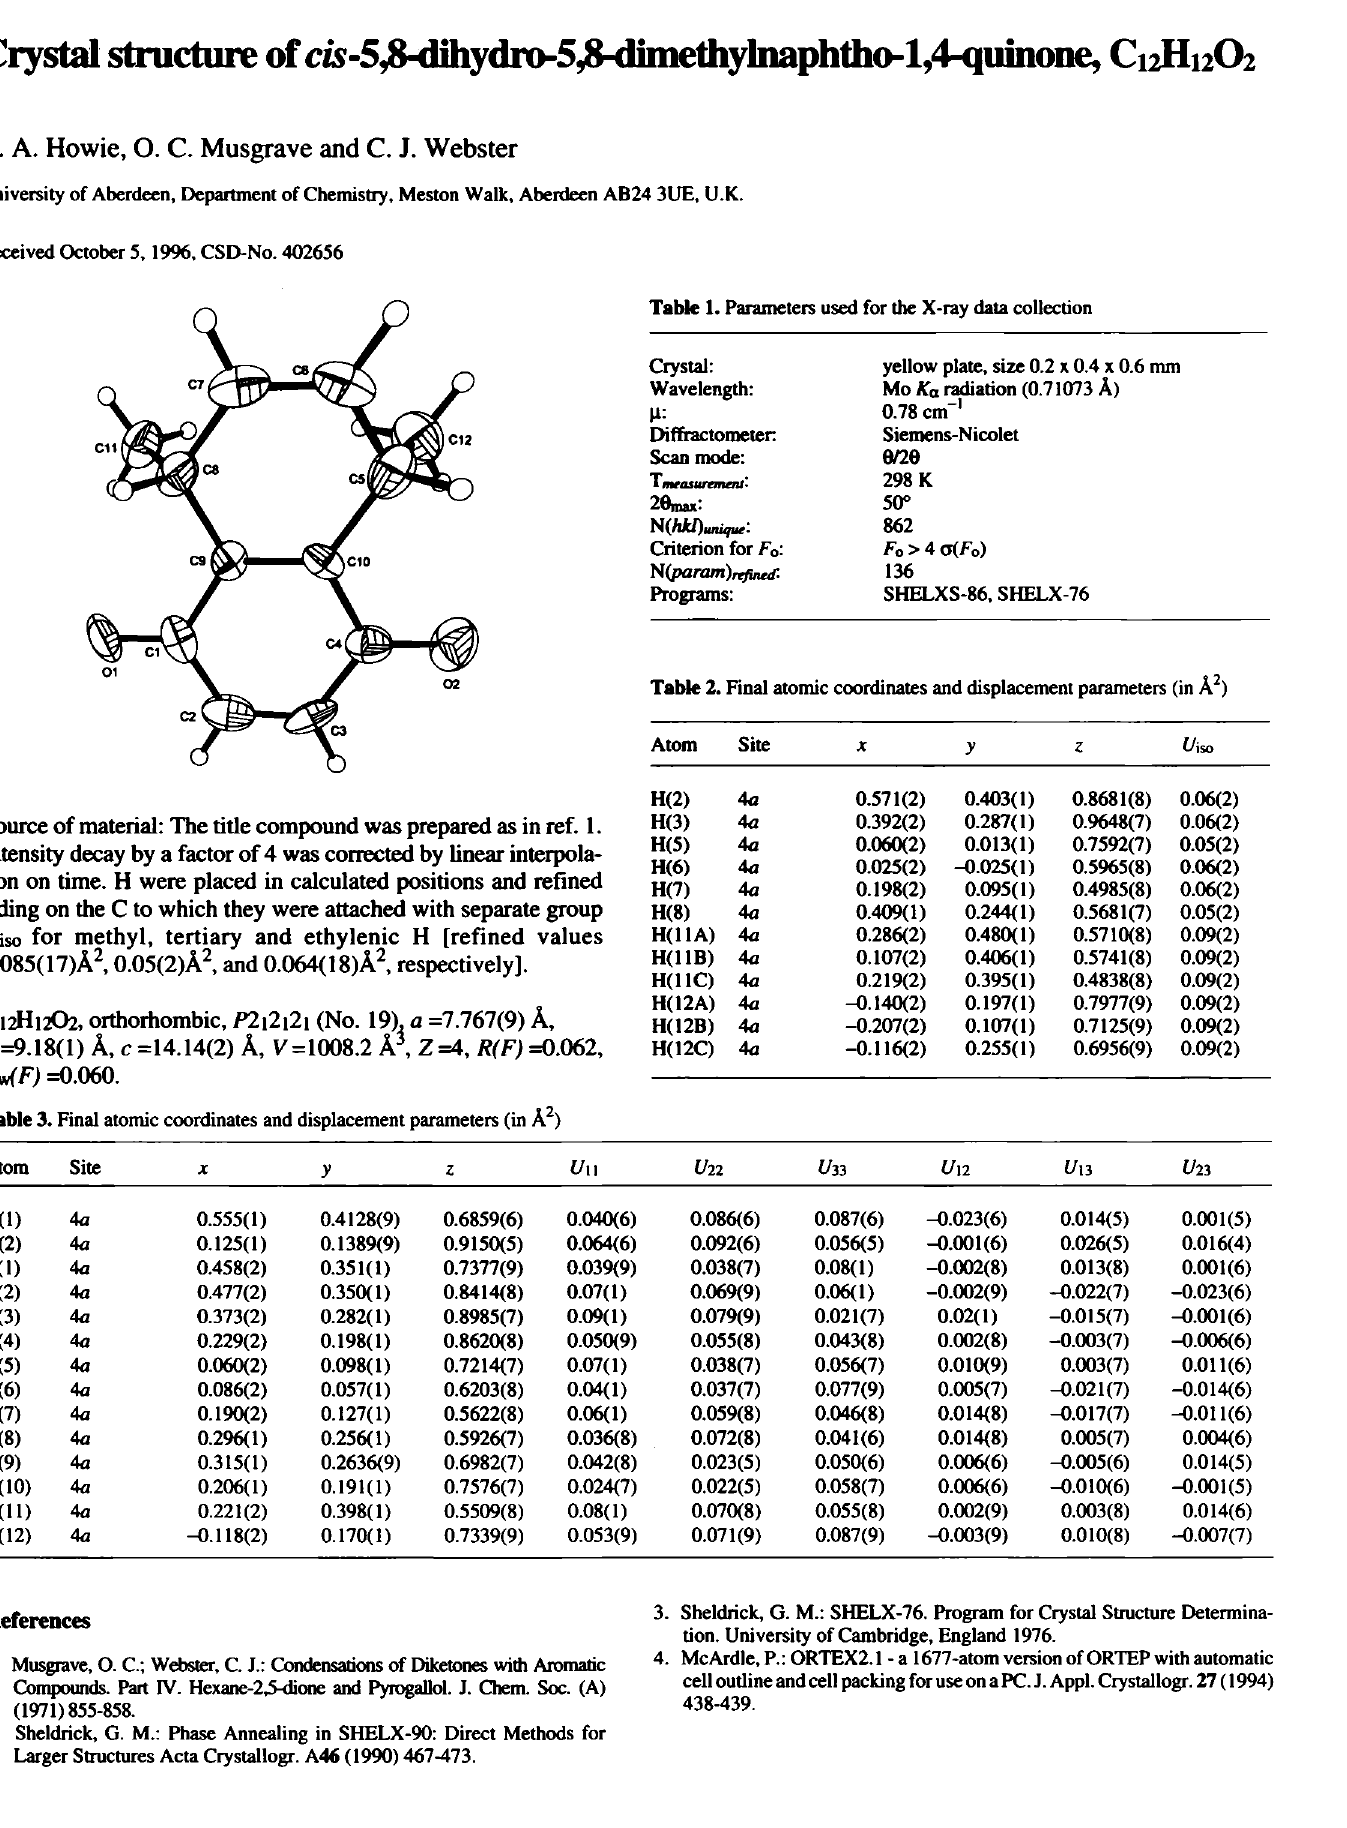
Table 1. Parameters used for the X-ray data collection